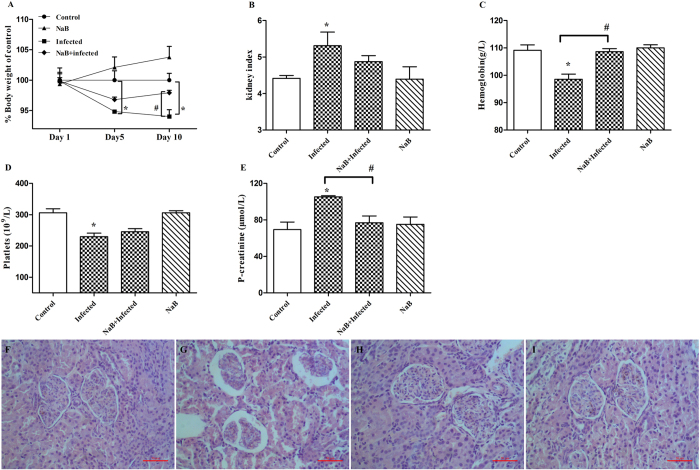
NaB alleviates clinical symptoms caused by E. coli O157:H7 inoculation.(A) Body weight is shown as a percentage of weight change from days 1 to 10. Pigs developed symptomatic diseases after inoculation with E. coli O157:H7. (B) Kidney index = kidney weight (g)/body weight (kg). (C) Hemoglobin (g/L), (D) platelet counts (/L), and (E) plasma creatinine levels were analyzed from precaval vein blood samples from the same pigs in (C) and (D). Data are presented as the mean ± SEM. *Indicates a significant difference (p < 0.05) compared to that of control group by One-way ANOVA. #Indicates a significant difference (p < 0.05) compared to that of infected group by One-way ANOVA. (F) Normal renal cortex from a pig. (G) Renal cortex from an E. coli O157:H7-challenged pig. (H) Renal cortex from a pig fed with NaB and challenged by E. coli O157:H7. (I) Renal cortex from a pig fed with NaB. The scale bar represents 50 μm.